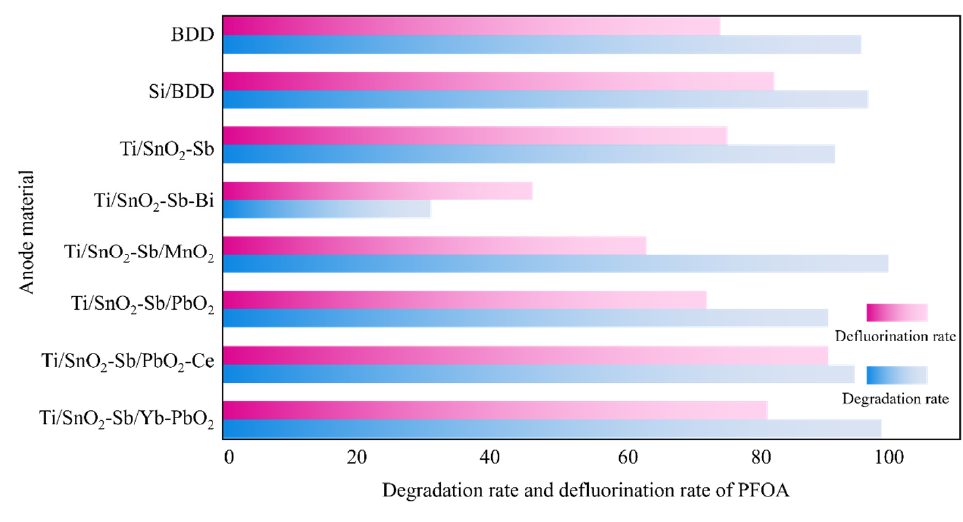
Figure 2. Oxidation effect of PFOA with different anodes.